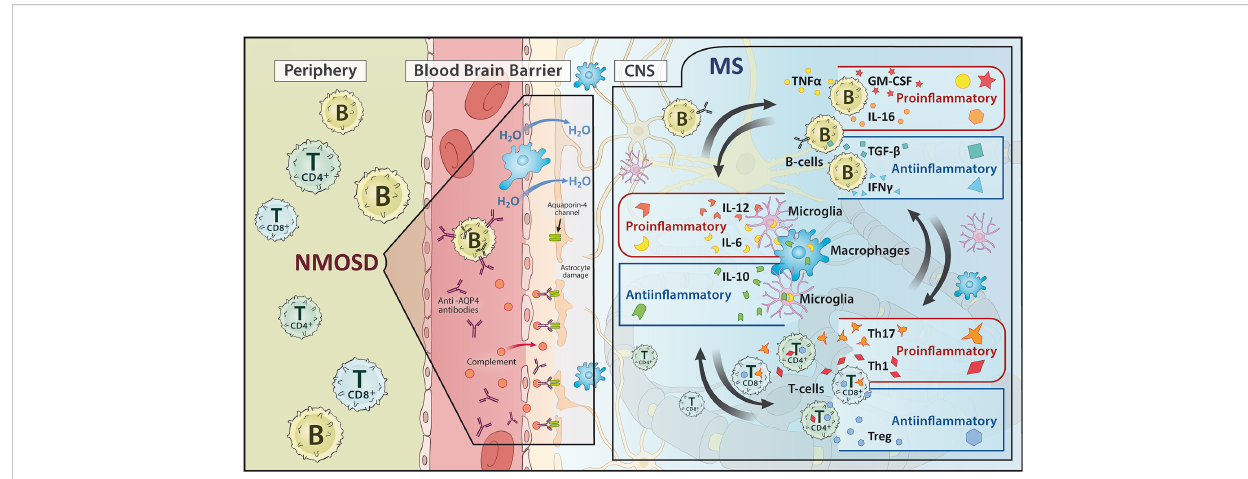
FIGURE 2 Schematic representation of the pathomechanism of (left) neuromyelitis optica spectrum disorders (NMOSD) and (right) multiple sclerosis (MS). While NMOSD focuses on an antibody reaction, MS shows an interplay of pro- and anti-in fl ammatory processes between B cells, T cells and